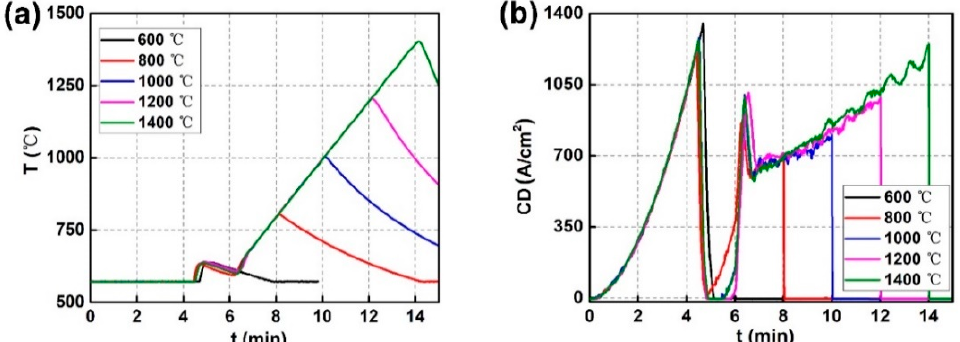
Figure 2. ( a ) The real-time temperature change curves and ( b ) the profiles of the current density (CD) change of the W foil laminates joined at different temperature.